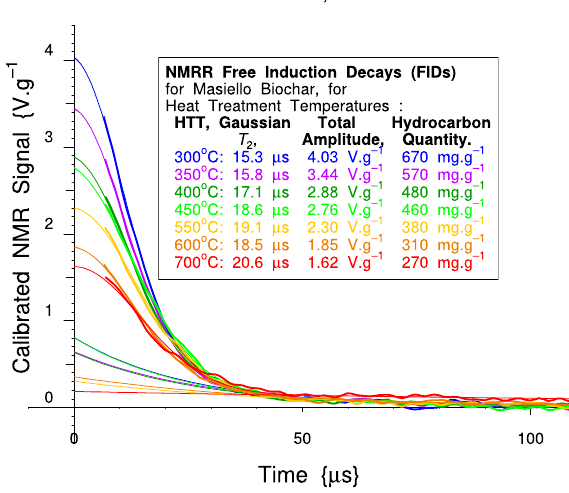
Fig. 15 Measurements of hydrocarbon quantity and dynamics/ mobility in the pores of biochar prepared at different heat treat- ment temperatures (HTTs)